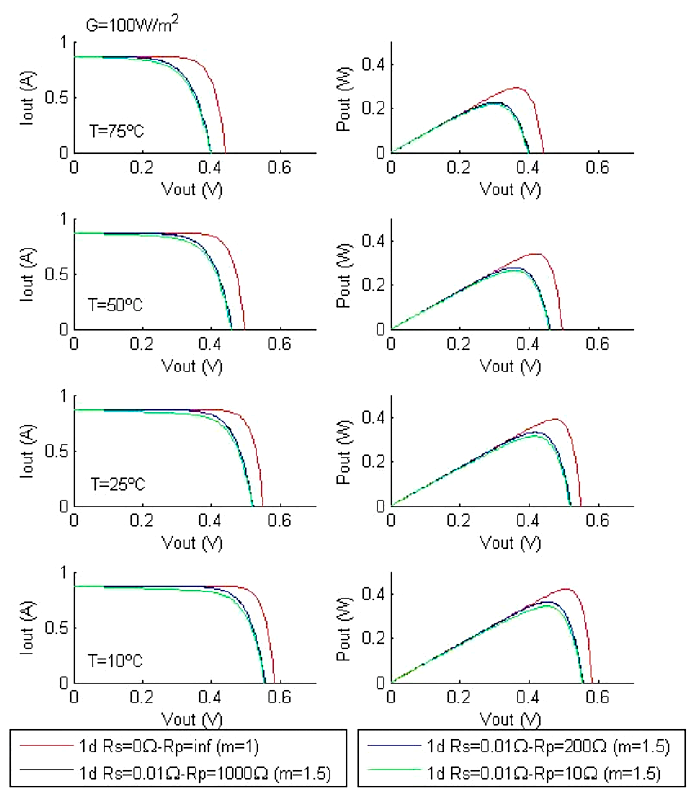
Figure 6. Characteristic curves in function of temperature and parallel resistance R p , with a constant resistance R s (G = 500 W/m 2 ).